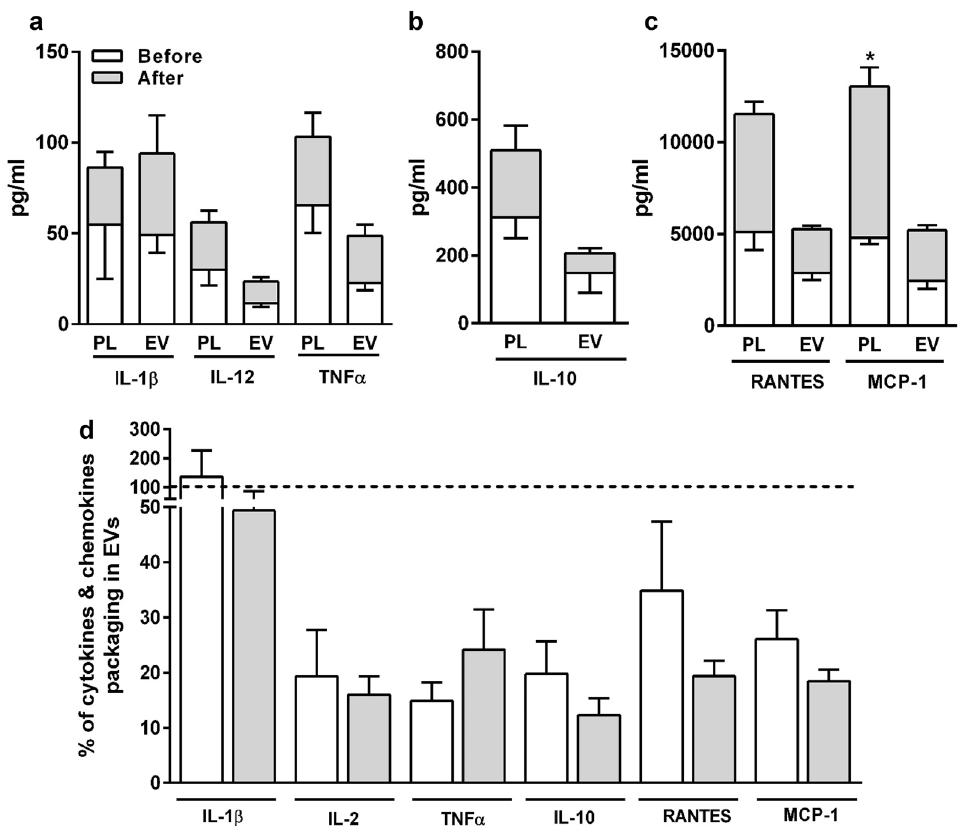
Figure 6. Levels of cytokines and chemokines in rat plasma and EVs. EVs were isolated from rat plasma obtained ‘before’ and ‘after’ self-administered nicotine in the presence of menthol and AV cue (NIC: Nicotine, AV: Audiovisual, Men: Menthol). ( a – c ) Multiplex ELISA analyses of proinflammatory cytokine (IL-1β, IL-2, TNFα), anti-inflammatory cytokine (IL-10) and chemokines (RANTES and MCP-1) were performed in plasma and EVs obtained ‘before’ and ‘after’ self-administered nicotine in the presence of either AV, menthol or combined (NIC + AV + Men). ( d ) % of cytokines and chemokines packaging in EVs. Statistical analyses were carried out by using one-way ANOVA. Results are expressed as means ± S.E.M. *p < 0.05 of n = 3–4 experiments, in comparison with plasma/EV obtained ‘before’ self-administered nicotine in respective